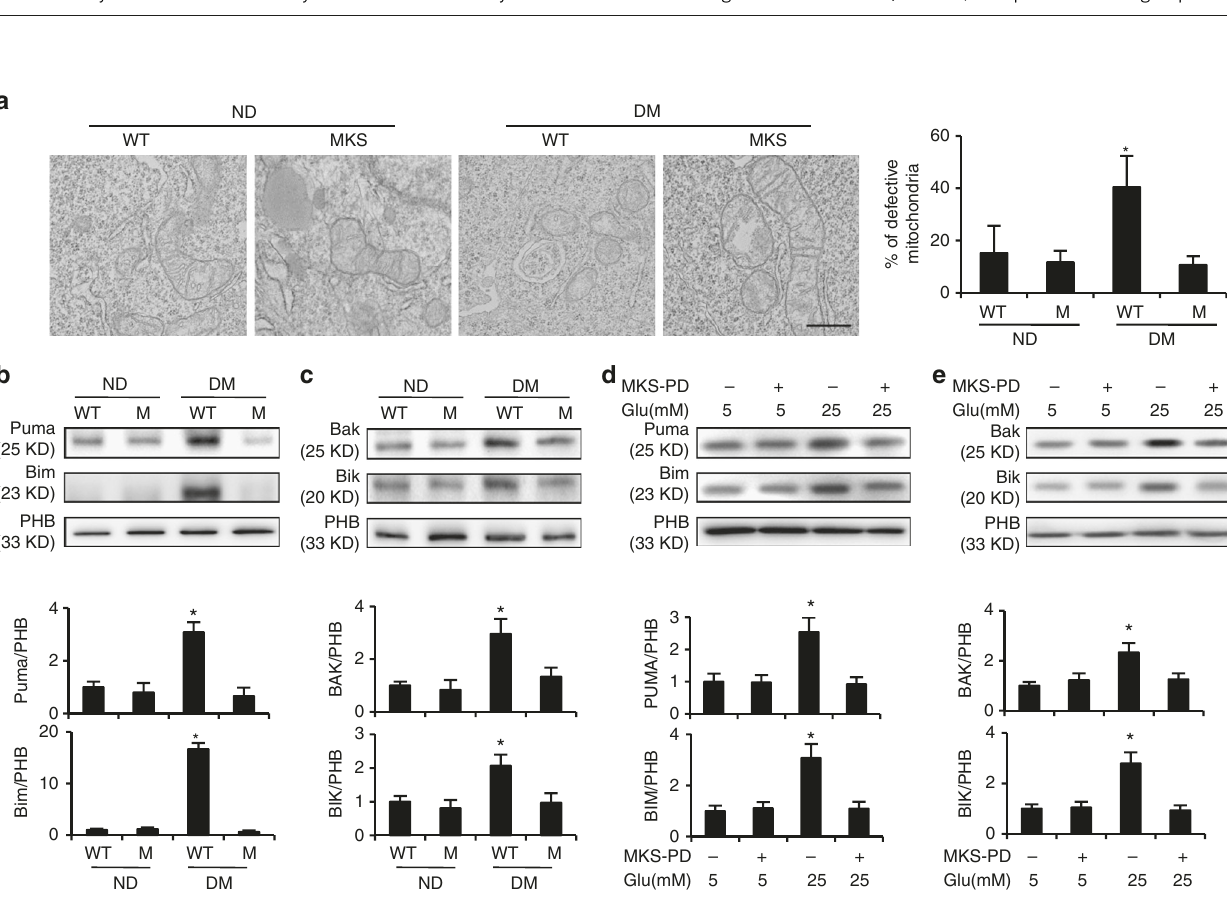
Fig. 3 MARCKS dissociation from mitochondria leads to mitochondrial abnormalities. a Defective mitochondria in the developing neuroepithelium examined by electron microscope. The bar graph was the quanti fi cation data of the percentage of defective mitochondria: the number of defective mitochondria number divided by the number of total mitochondria in a given area. Bar indicates 1 μ M. b Mitochondrial abundance of Puma and Bim in embryos. c Abundance of Bak and Bik in the mitochondria isolated from embryos. Quanti fi cation data was shown in the bar graph. d , e Abundance of Puma, Bim, Bak and Bik in the mitochondria isolated from cultured cells. MKS MARCKS, M: MARCKS-PD, ND: nondiabetic, DM: diabetes mellitus. NG: normal glucose (5 mM), HG: high glucose (25 mM). All experiments were repeated three times. In b and c , one embryo from one dam in one group were performed for one run. Each experiment was repeated three times with three embryos ( N = 3) from three different dams in one group. All quanti fi cation data were indicated as means ± standard derivation. One way ANOVA with the Tukey test was used to analyze the data. * Indicates signi fi cant difference ( P < 0.05) compared to other groups